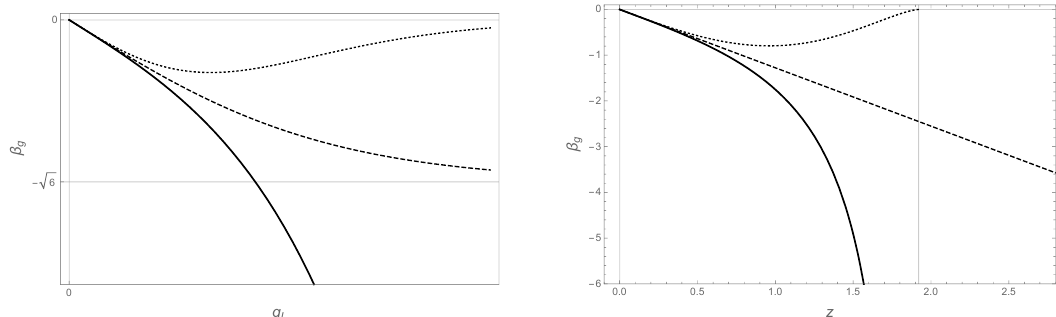
Figure 2 . Left: beta functions as functions of the dimensionless coupling g L . The solid line represents the beta function of the dimensional renormalization scheme, (4.18). The dashed line represents the ‘holographic beta function’ (3.30) and the dotted line the ‘proper beta function’ (4.19) as de(cid:12)ned in [38]. Right: the same three beta functions, but as a function of the inverse-energy scale z . This is obtained by substituting the solution for the running coupling (4.15) with a generic initial condition g L = 1 at L = 1 into the beta